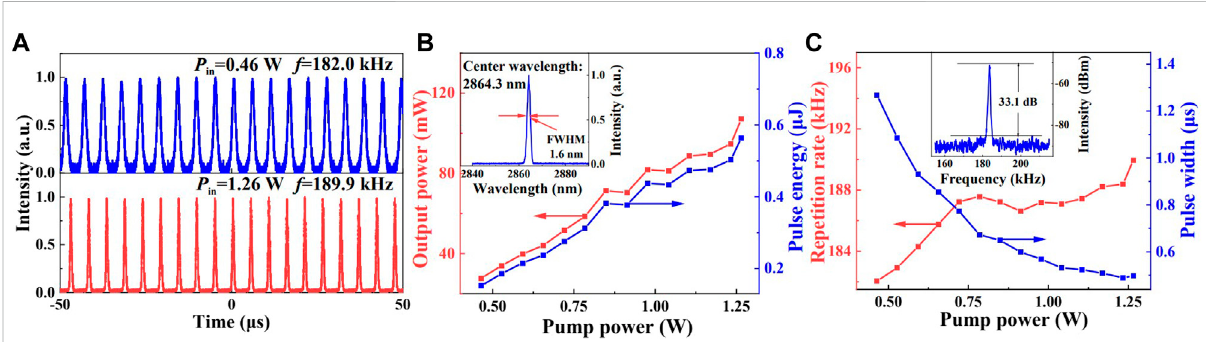
FIGURE 9 (A) Q-switched pulse trains at the launched pump power of 0.46 W and 1.26 W; (B) Output power and single-pulse energy as functions of the pumppower, inset:opticalspectraoftheQ-switchedpulses; (C) repetitionrateandpulsewidthasfunctions ofthepumppower,inset: RFspectraof the Q-switched pulses.